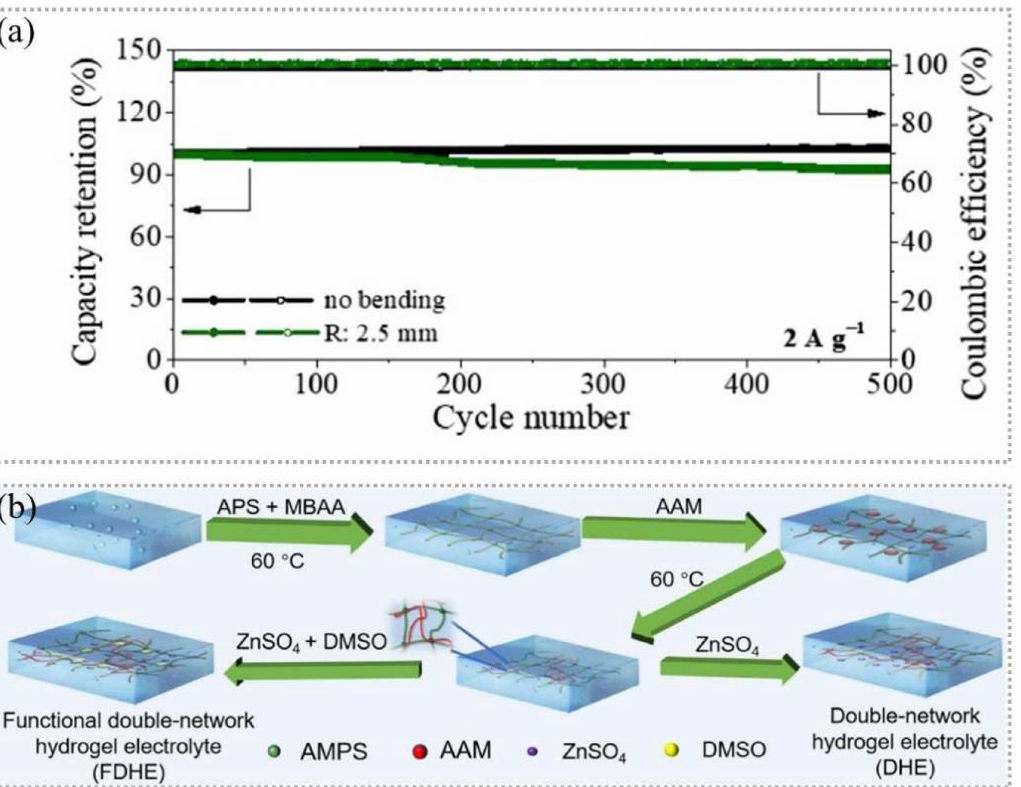
Figure 3. ( a ) Long-term cycling at 2 A g − 1 upon bending at a curvature radius of 2.5 mm. Adapted with permission from Ref. [43]. Copyright 2021 Energy Storage Materials. ( b ) Schematic diagram of the synthesis of PAMPS/PAAM dual-network hydrogel. Adapted with permission from Ref. [44]. Copyright 2022 Chemical Engineering